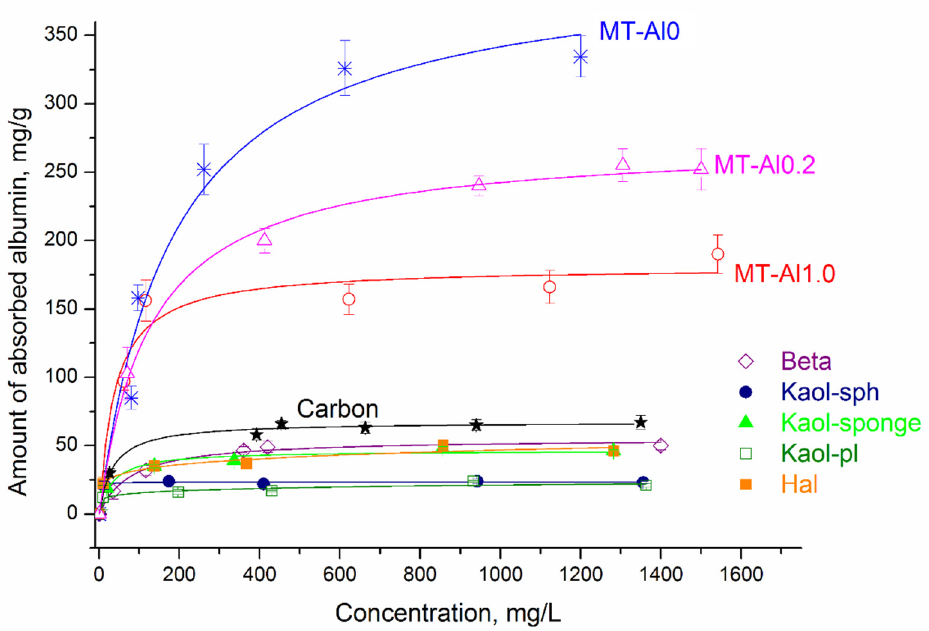
Figure 6. Langmuir and Freundlich adsorption isotherm plots. Langmuir isotherm: MT-Al0; MT- Al1.0; MT-Al0.2; Beta; Kaol-sph; Kaol-sponge; carbon samples. Freundlich isotherm: Hal and Kaol- pl. Table 4. Equation constants of albumin sorption isotherms.